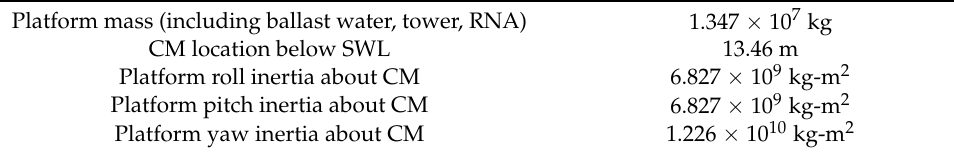
Table 1. Reference platform structural properties. Platform mass (including ballast water, tower,